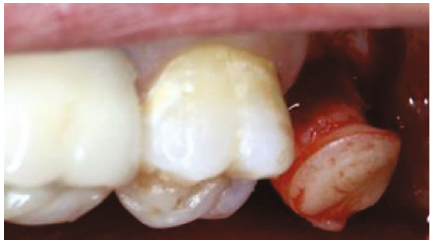
Figure 2: The “ one-piece ” tuberosity graft